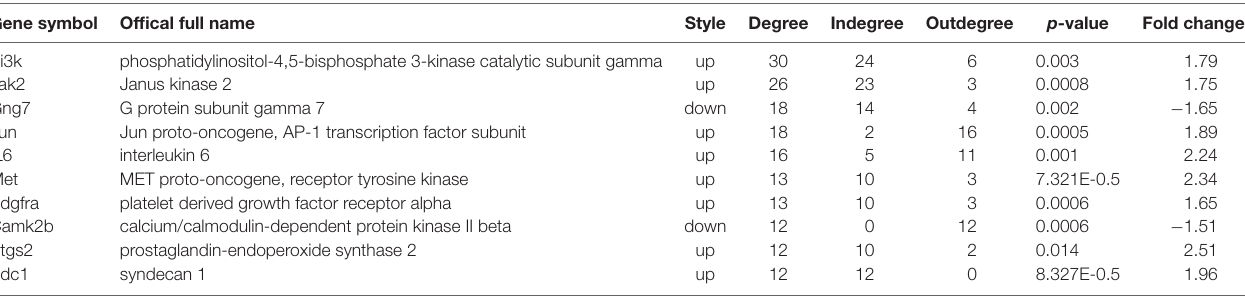
TABLE 2 | Ten key genes identified by global signal transduction network